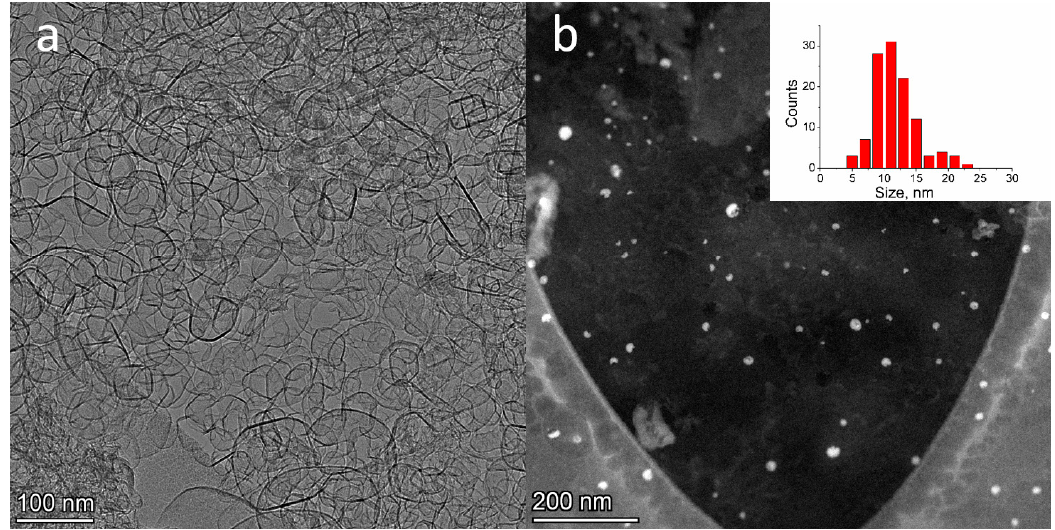
Figure 2. TEM and HAADF STEM images of N-graphene ( a ) and 0.2 wt.% Pt/N-graphene. (Pt(NO 3 ) 4 ) ( b ).